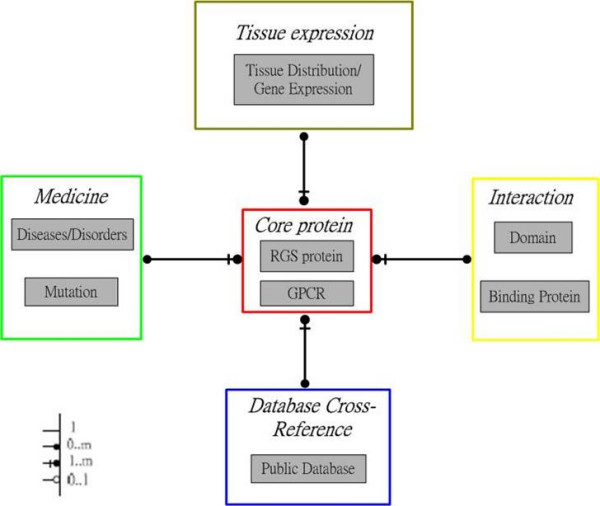
The simplified relational scheme of RINGdb. Each gray box represents an entity with various attributes. Most entities in our databases could be classified into five categories, Core protein, Interaction, Medicine, Tissue expression and Database Cross-Reference. For instance, each RGS protein may contribute to one or more Diseases/Disorders or not be discovered to relate to any Diseases/Disorders yet.